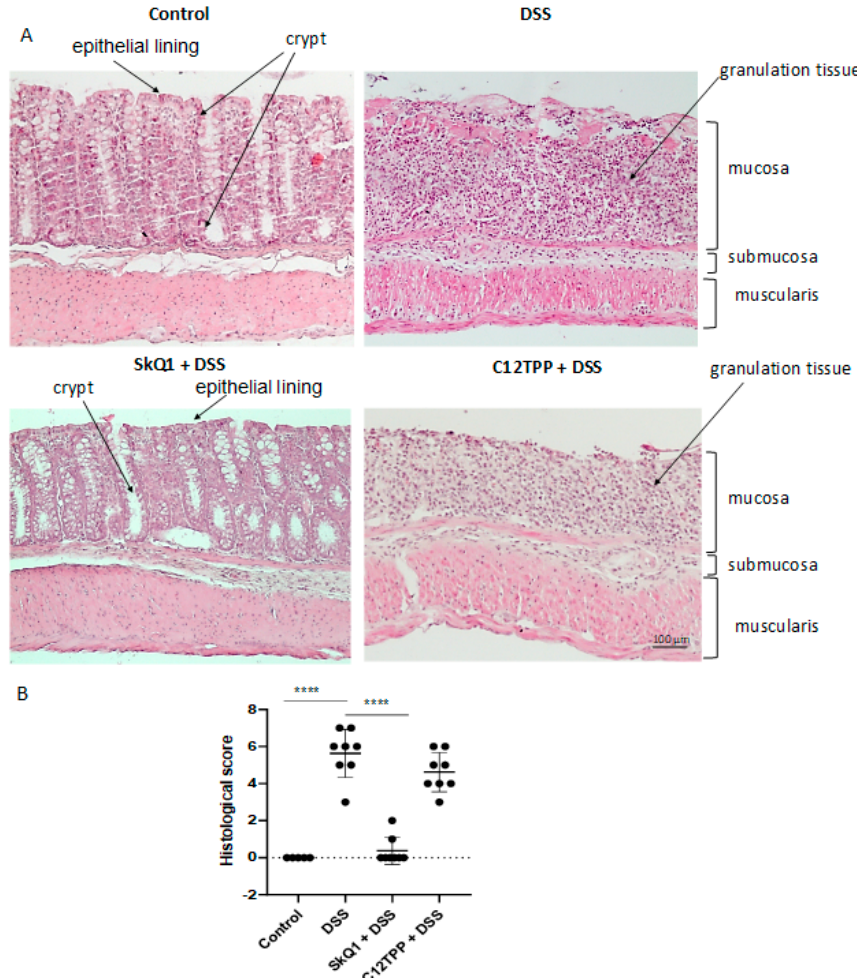
Figure 2. Effect of SkQ1 and C 12 TPP on the microscopic structure of the distal colon in mice with DSS-induced colitis. Animal groups are indicated in Figure 1. ( A ) Representative sections of the distal colon stained with hematoxylin and eosin. ( B ) Results of histological assessment of the extent of damage to the colon. Results are expressed as mean ± SD (n = 5 − 9). **** p < 0.0001 as compared with the DSS-treated mice.